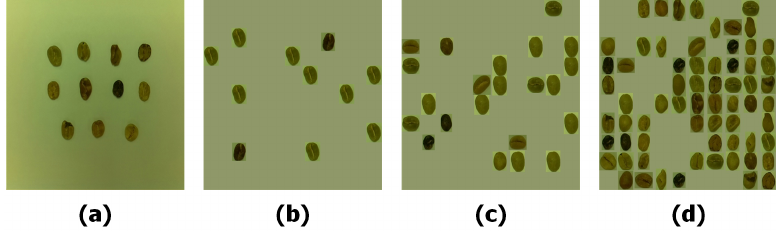
Figure 13. Augmented bean images: ( a ) original, ( b ) low density, ( c ) medium density, ( d ) high-density.